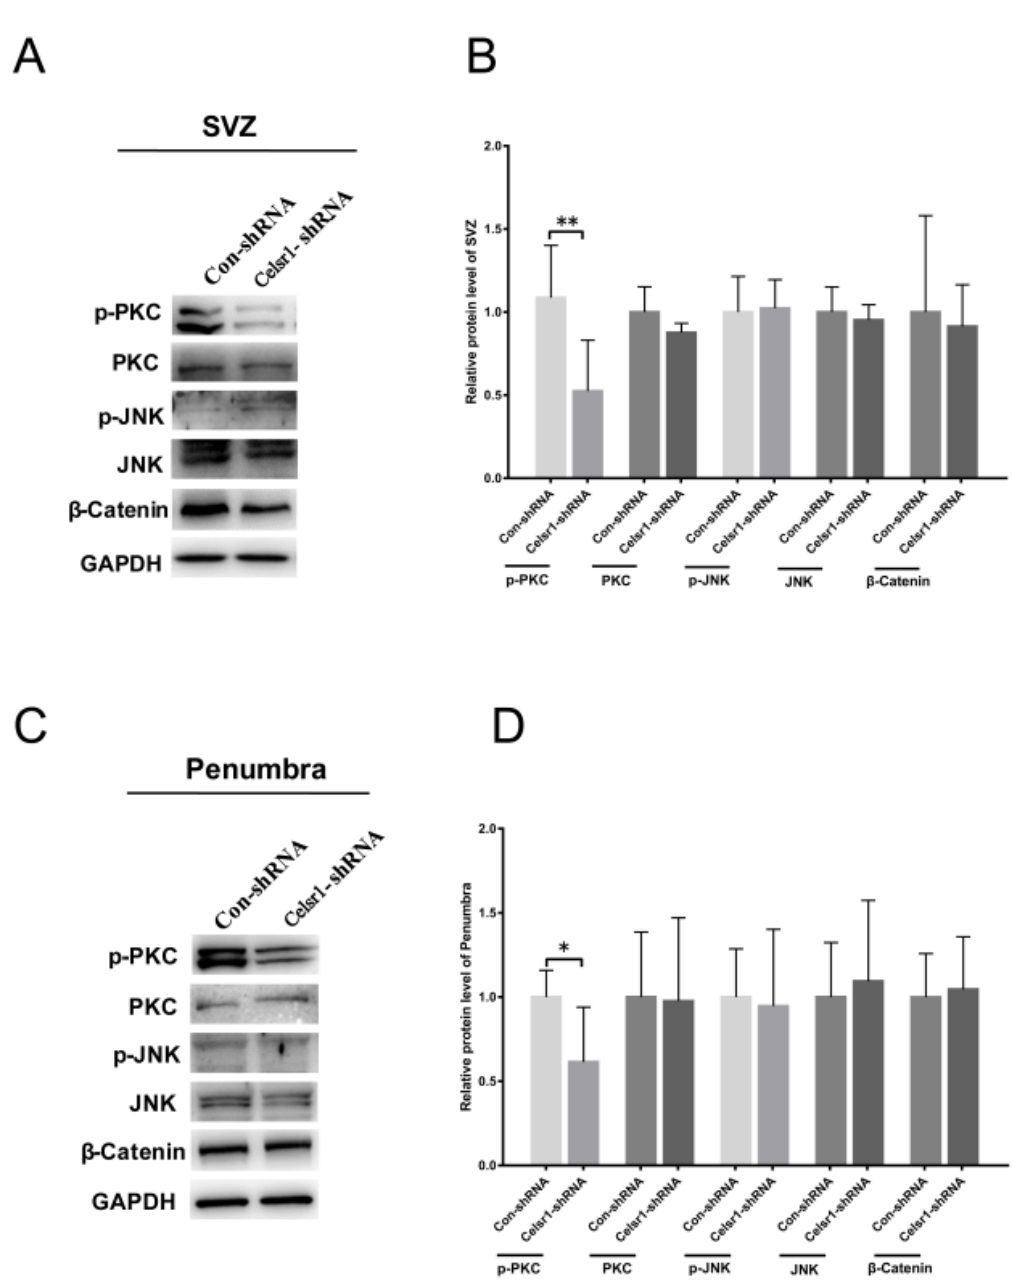
Figure 5. CELSR1 regulates neurogenesis after cerebral ischemia through the Wnt / PKC signaling pathway. ( A ) Celsr1 knockdown in the SVZ significantly reduced the level of p-PKC, but the levels of p-JNK and β -catenin did not change. ( B ) The protein levels in the SVZ were quantified relative to the level of GAPDH. ( C ) The level of p-PKC was significantly reduced in the ischemic penumbra. ( D ) The protein levels in the penumbra were relative to the level of GAPDH, and three independent experiments were performed. The reported data represent the mean of the three experiments, Student’s t -test, * p < 0.05, ** p < 0.01 (Con-shRNA group, n = 6; Celsr1 -shRNA group, n = 6).